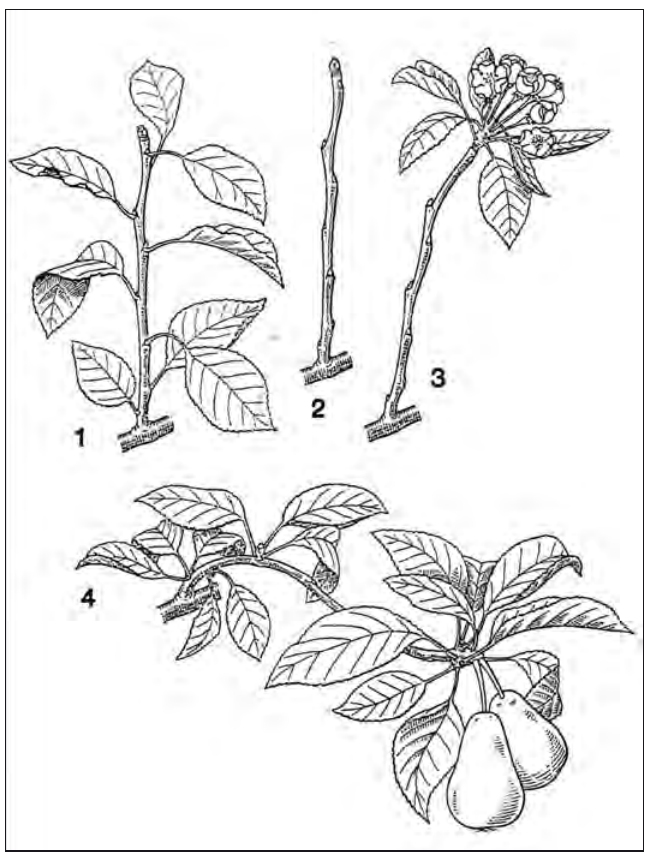
Fig. 8 - Natural variation in growth direction of a pear brindle with an apical fruit bud (from Grisvard,